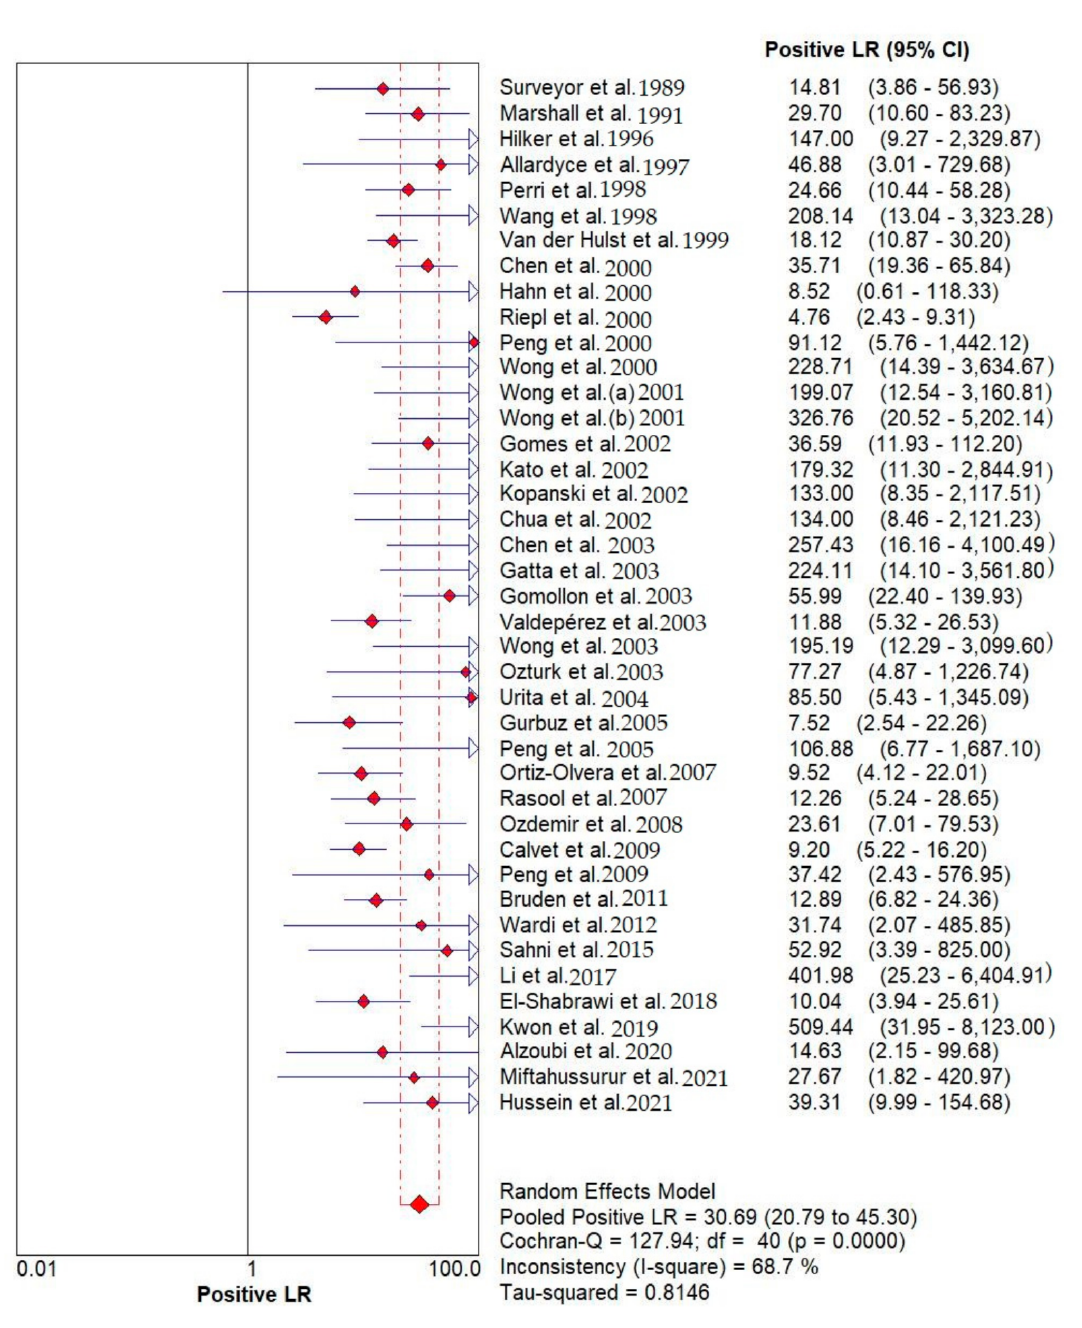
Figure 4. Pooled urea breath test result. Overall likelihood ratio for positive test